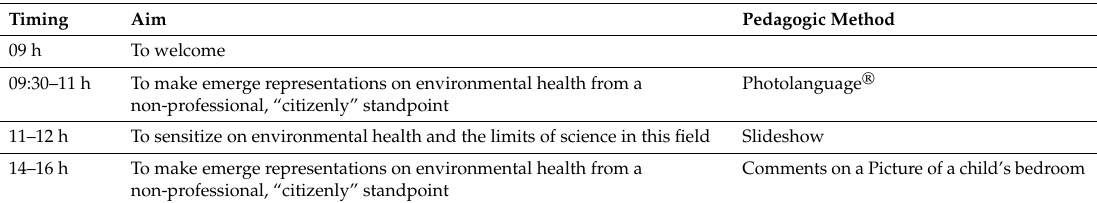
Table 1. Program of training